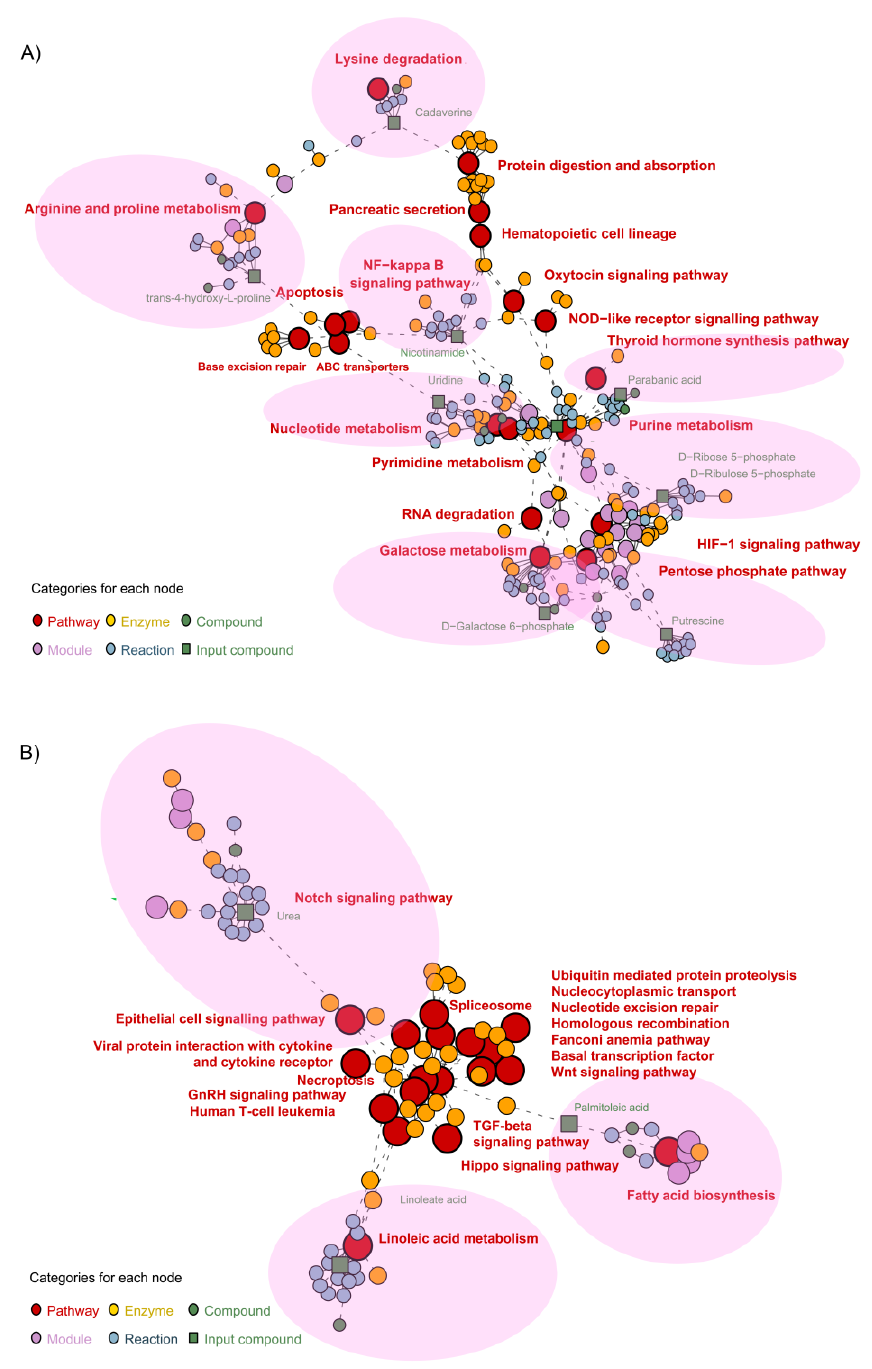
Figure 5. Metabolite pathway enrichment analysis of TNF α - and TGF β 2-treated H-RPE cells vs. control. Network enrichment analysis of the most differentially expressed metabolites for ( A ) TNF α - and ( B ) TGF β 2-treated H-RPE. Primary pathways affected are indicated by the pink shaded regions.